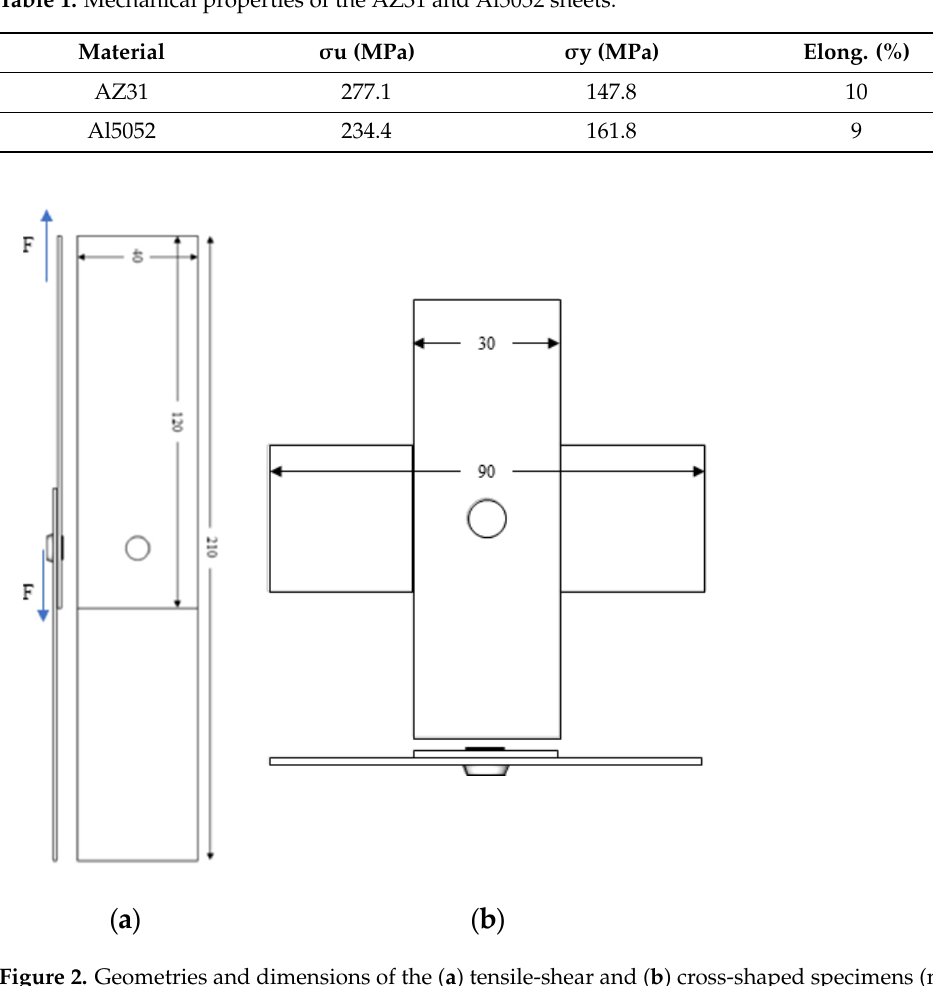
Table 1. Mechanical properties of the AZ31 and Al5052 sheets.